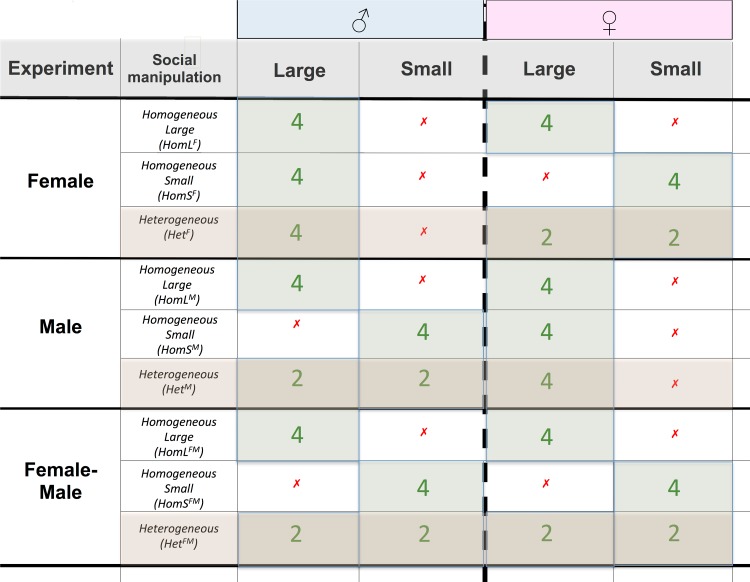
Diagram of the experimental design.We investigated the effects of the developmental environment on the strength of sexual selection. Because larval density strongly influences adult body size we refer to low-larval density flies as “large” and high larval density flies as “small”. The Female Experiment–experiment varying female larval density, keeping males constant (low larval density). Homogeneous social environments consisted of 4 large or 4 small females in addition to 4 large males. Heterogeneous social environments consisted of 2 large and 2 small females in addition to 4 large males. The Male Experiment–experiment varying male larval density, keeping females constant. Homogeneous social environments consisted of 4 large or 4 small males in addition to 4 large females. Heterogeneous social environments consisted of 2 large and 2 small males. The Female -Male Experiment–experiment varying both male and female larval density. Homogeneous social environments consisted of 4 large males and females or 4 small males and females. Heterogeneous social environments consisted of 2 large males and females and 2 small males and females. In all experiments one male, out of each group of four, was the focal individual for which we obtained paternity data (see methods).